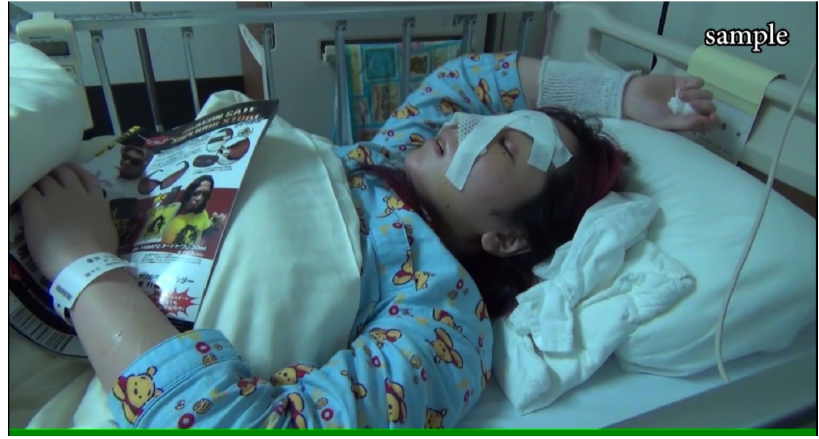
Fig. 4. In bed with a puroresu magazine. After Gamushara (Takahara,